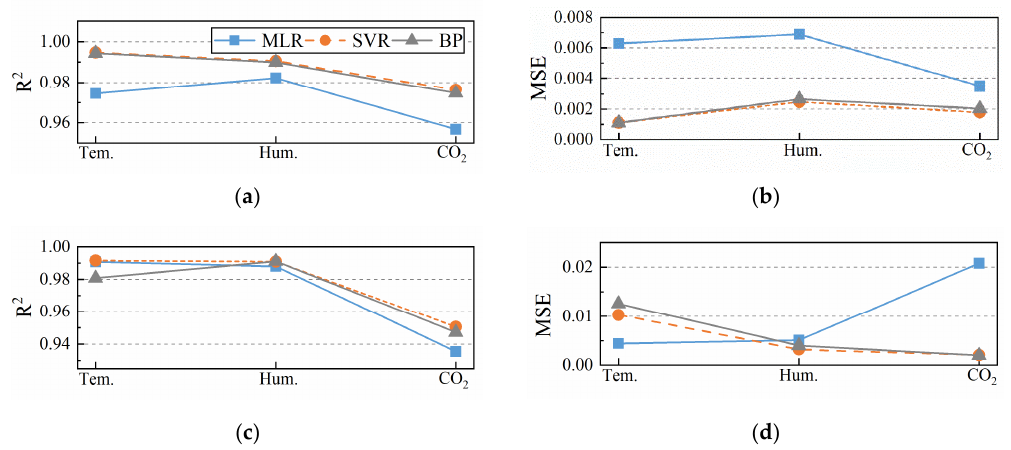
Figure 9. Reconstruct data prediction results based on three models: ( a ) Temperature; ( b ) Humidity; ( c ) CO 2 concentration.